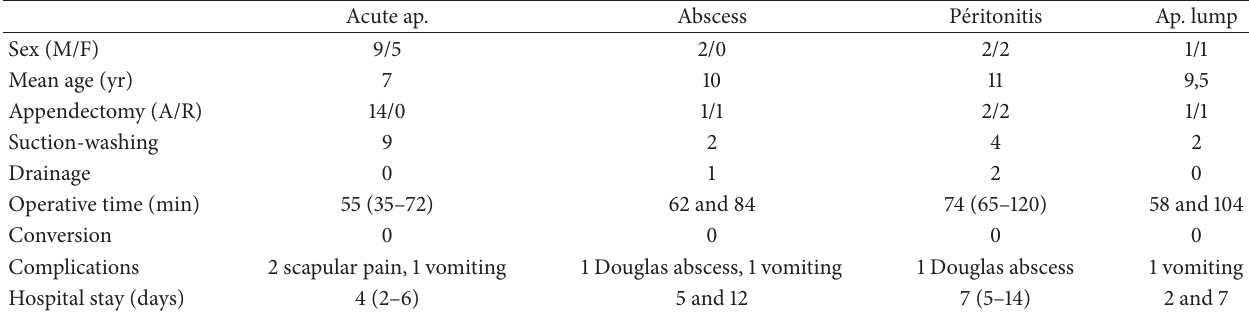
Table 1: The patients’